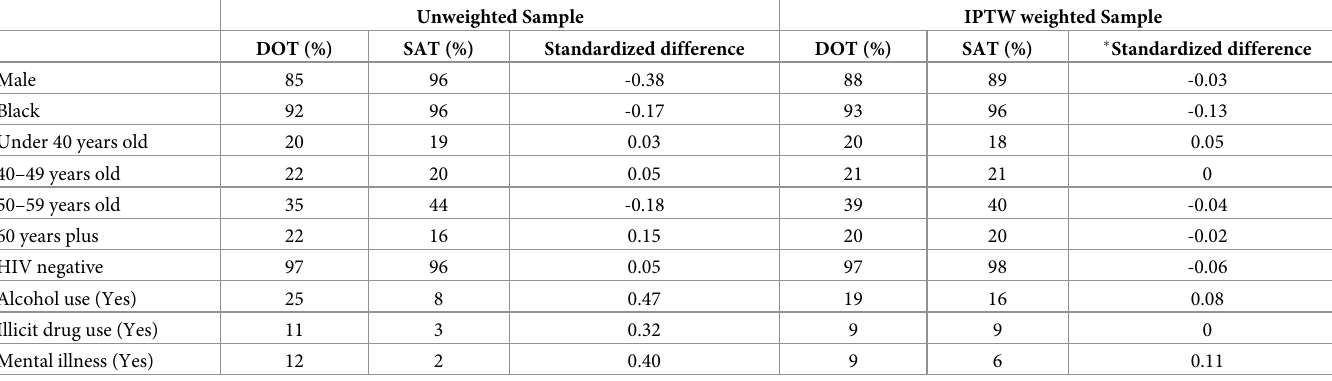
Table 2. Balance assessment using standardized